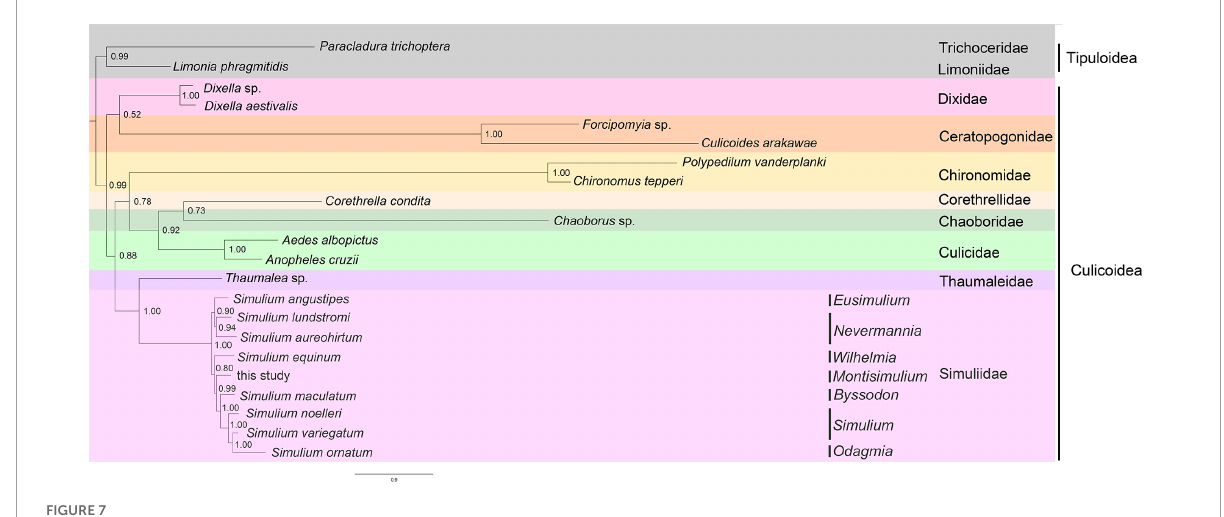
FIGURE7 Phylogenetic trees inferred from PhyloBayes analysis based on the concatenation data of